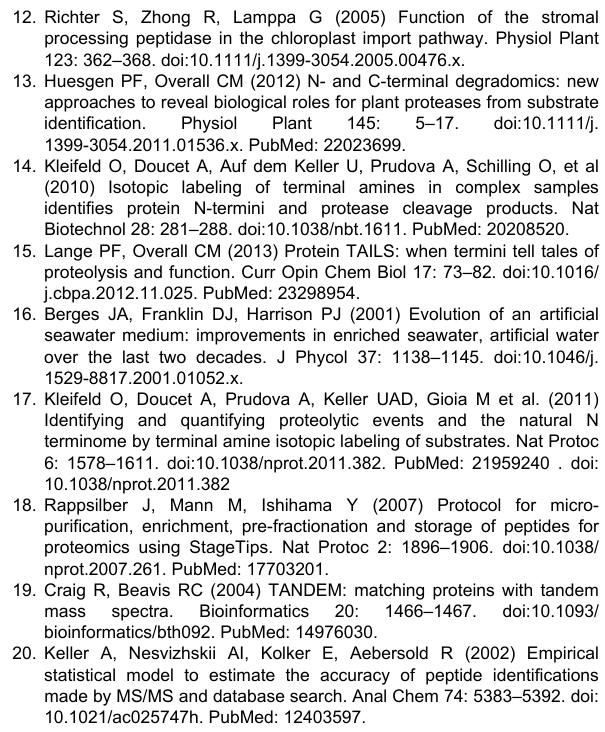
Table S6. List of 106 unique N terminal peptides from 37 plastid-encoded T. pseudonana proteins. A non-redundant list of unique N terminal peptides, identified by database searches with Mascot and X! Tandem, was generated using an in-house script (see methods section for details). CpBase ID, CpBase protein model accession number; peptide, peptide sequence; position, peptide start position as matched to protein sequence; identifying the N-terminally dimethylated form of this peptide; spectra (acetylated), number of spectra identifying the N- terminally acetylated form of this peptide; gene name, CpBase gene name annotation.